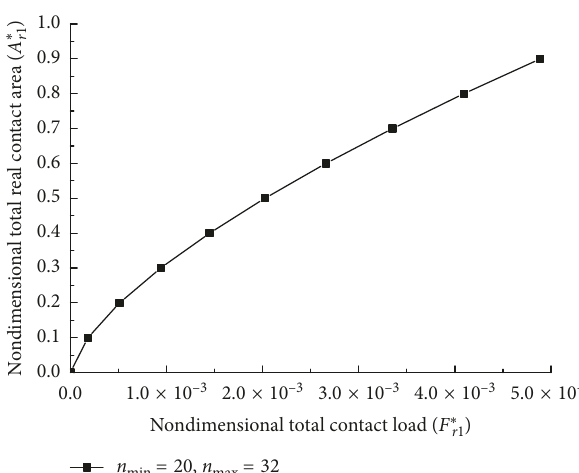
Figure 11: The relationship between dimensionless total real contact area and the dimensionless total contact loading for 44 ≤ n ≤ 50.